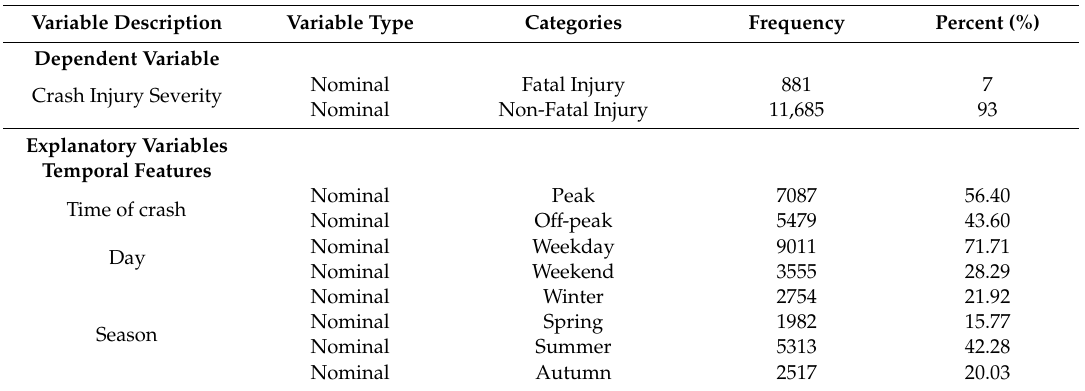
Figure 1. Locations of crashes in the study area. Table 1. Descriptive statistics of variables.